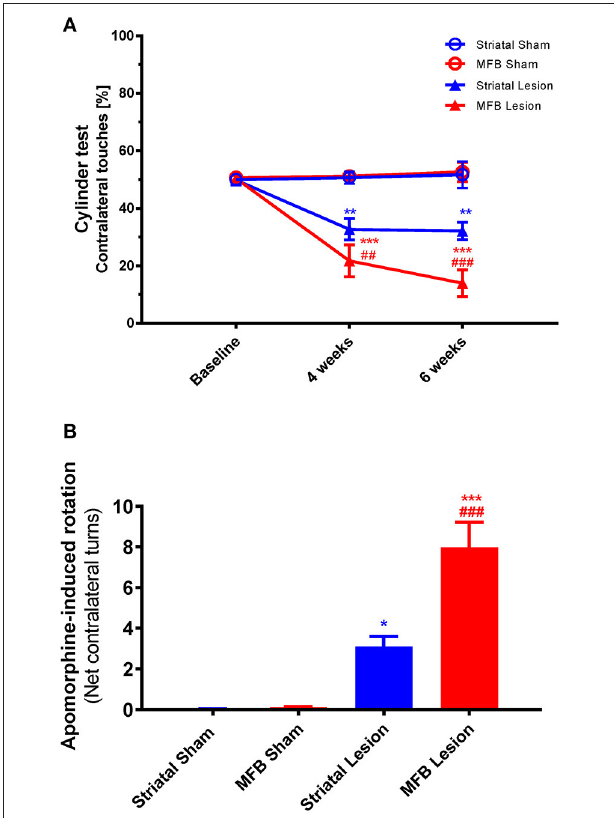
FIGURE 8 | Cylinder test and Apomorphine-induced rotation following MFB and striatal 6-OHDA lesioning. (A) Percentage contralateral touches. (B) Net contralateral turns per minute. Data shown as mean ± s.e.m. *Indicates a significant difference on the lesion group when compared to its control (blue for striatal cohort and red for MBF cohort) and # indicates differences of MFB lesion vs. striatal lesion animals. * P ≤ 0.05; ** P < 0.01; *** P < 0.001 [Two-way repeated measures ANOVA with Tukey’s post-hoc multiple comparison for (A) , and one-way ANOVA with Tukey’s post-hoc for (B)